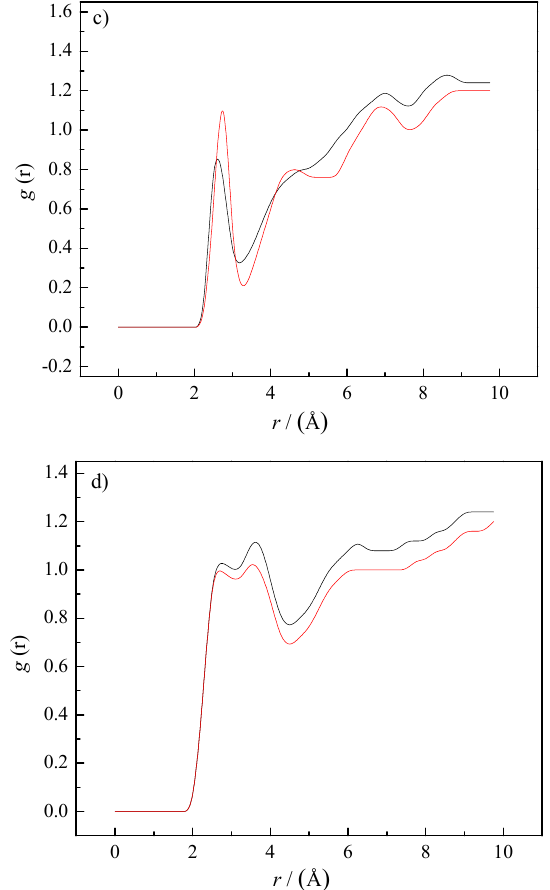
Figure 9. Radial distribution functions of water oxygen atom around selected atoms of caffeine in aqueous solution (black lines) and the presence of SS (red lines): ( a ) O1-Ow, ( b ) O2-Ow, ( c ) N4-Ow, and ( d ) H1-Ow.